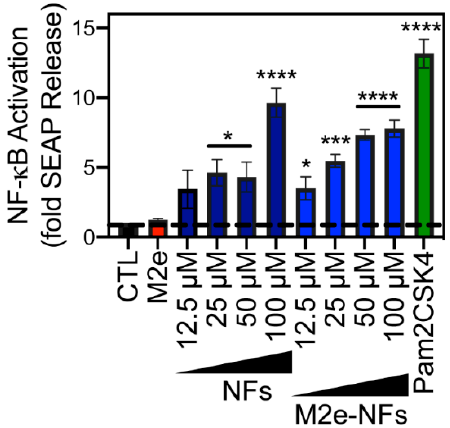
Figure 6. M2e-NFs activate TLR2/6. HEK-Blue hTLR2-TLR6 cells were stimulated with increasing concentrations of NFs and M2e-NFs (ranging from 12.5 to 100 µM), 150 µM of M2e peptide, 10 ng/ml of Pam2CSK4 or with the PBS buffer (CTL) for 16 h. NF- κ B-induced SEAP activity was quantified using HEK-Blue detection media. Data represent the mean ± S.D. of at least three experiments performed in triplicate. Results were analyzed using the student’s t-test and statistical difference (between control cells and treated cells) was established at (*) 0.01; (**) 0.001; (***) 0.0001; (****) < 0.0001.